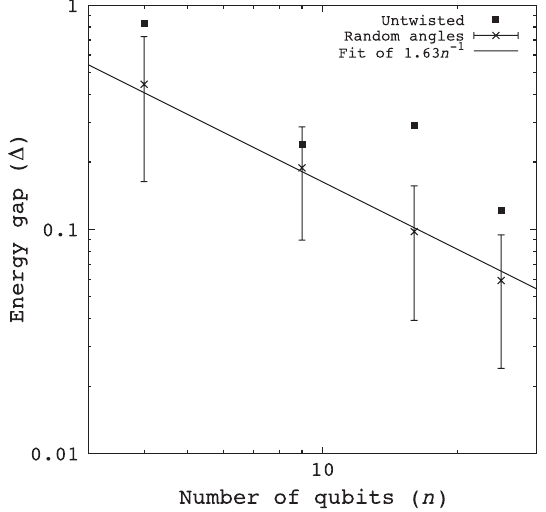
FIG. 6. Energy gap versus number of qubits for the two- dimensional twisted Hamiltonian with random angles and the duality condition enforced (see text.) The initial Hamiltonian was a rotated-cluster Hamiltonian for a square lattice [Eq. (1)], and the final Hamiltonian was an X field over the entire device. All data were obtained using exact diagonalization with accuracy 10 (cid:1) 8 , with the exception of the random angle data for n ¼ 25 , which were obtained using a one-dimensional matrix product algorithm wrapped onto the two-dimensional lattice and